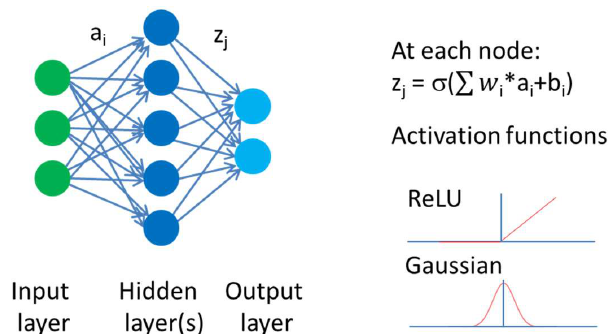
Figure 1. Neurons are connected to each other. Incoming signals are multiplied by a weight. The output signal z j is given by the sum of this products plus a bias transformed by an activation function. Examples of activation functions are graphically shown, like the rectified linear unit (ReLU) or the Gaussian function. For each neuron in the neural net, weights and biases need to be trained. Deep neural networks have several hidden layers with many neurons. The number of neurons typically varies between different layers.